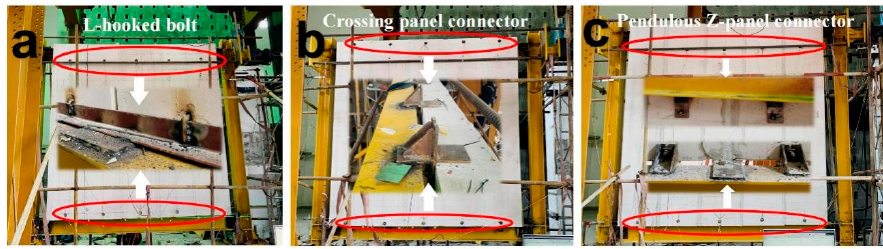
Figure 3. Overview of the test specimens: ( a ) SFW1; ( b ) SFW2; ( c ) SFW3.